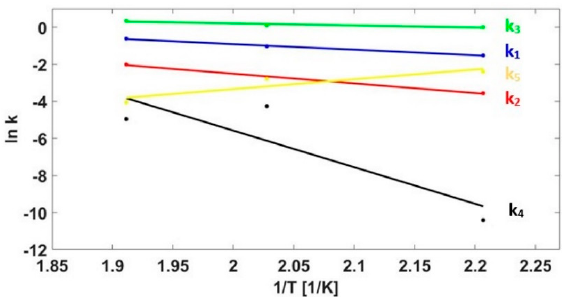
Figure A4. Arrhenius plot for determination of the activation energies (E a,i ) and pre-exponential factors (k 0,i ) for olive trimmings, fixing n = 1.